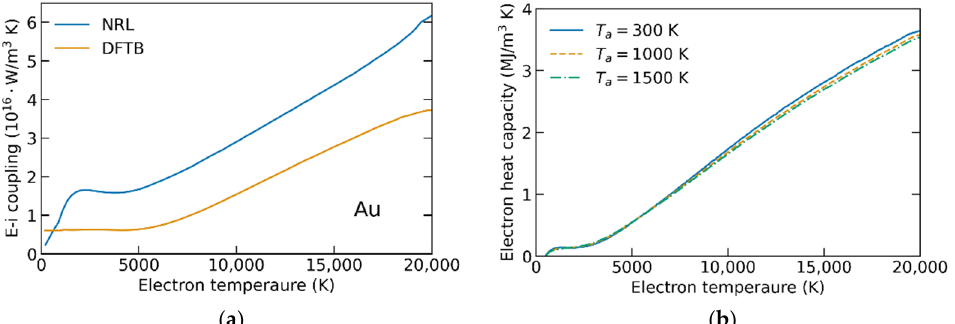
Figure 3. ( a ) Electron–ion couplings G(T e ) in gold calculated using NRL and DFTB parametrizations. ( b ) Electron heat capacity in gold calculated for different atomic temperatures.